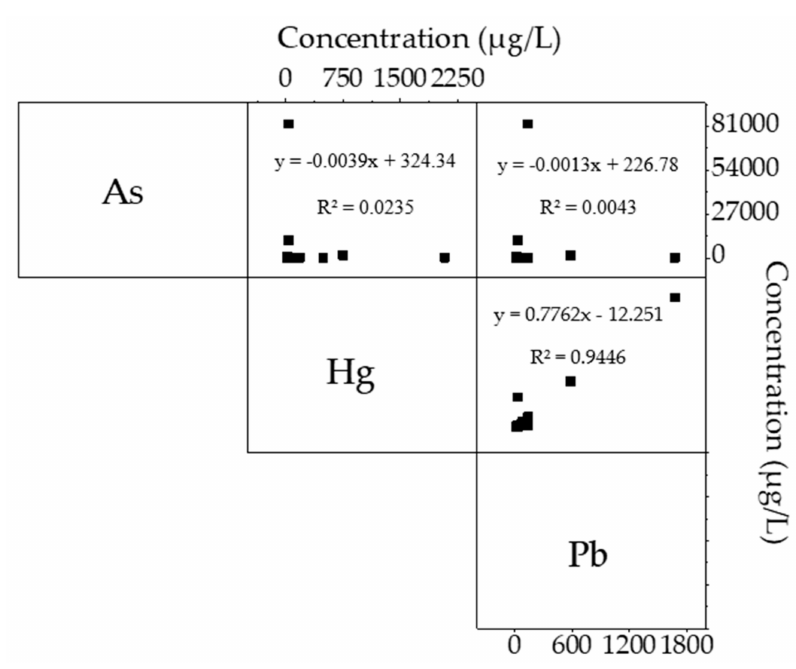
Figure 3. Relationship between As, Hg, and Pb in water samples from the upper course to the lower course of Bone